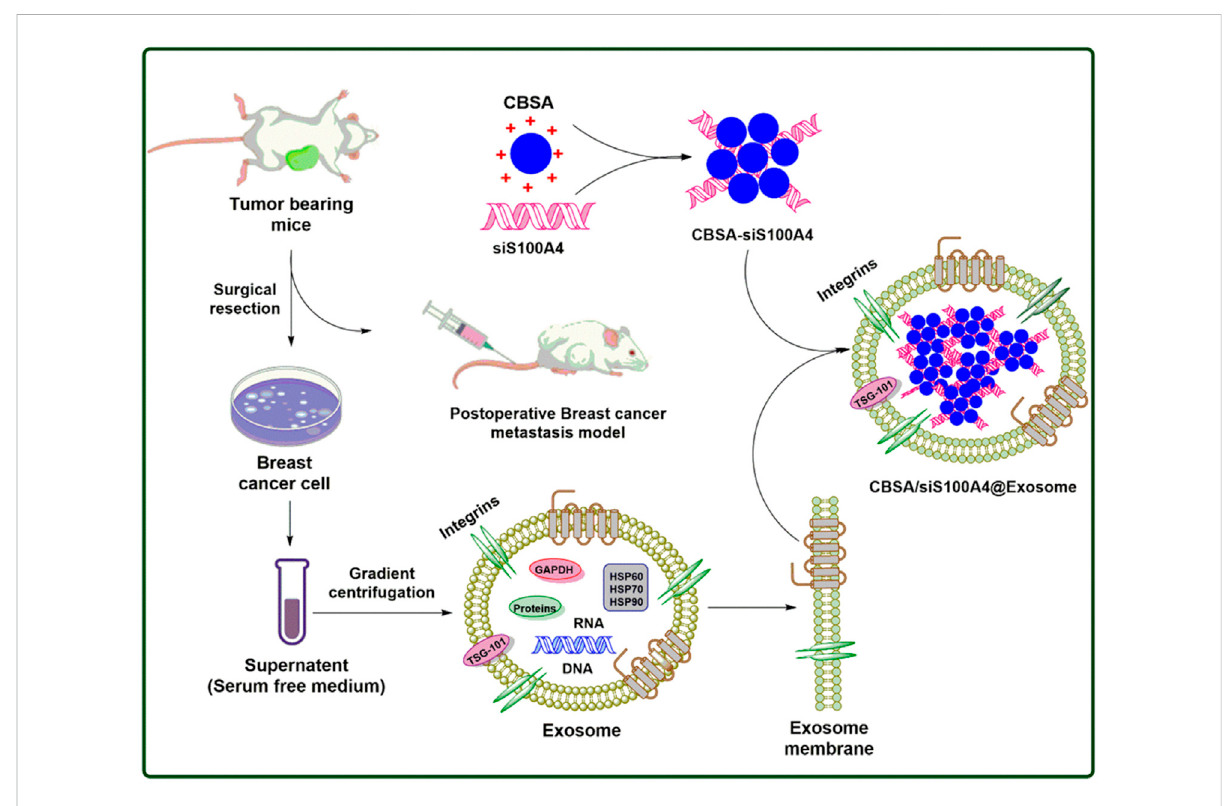
FIGURE 2 Postoperative breast cancer metastatic suppression via exosome-mediated siRNA